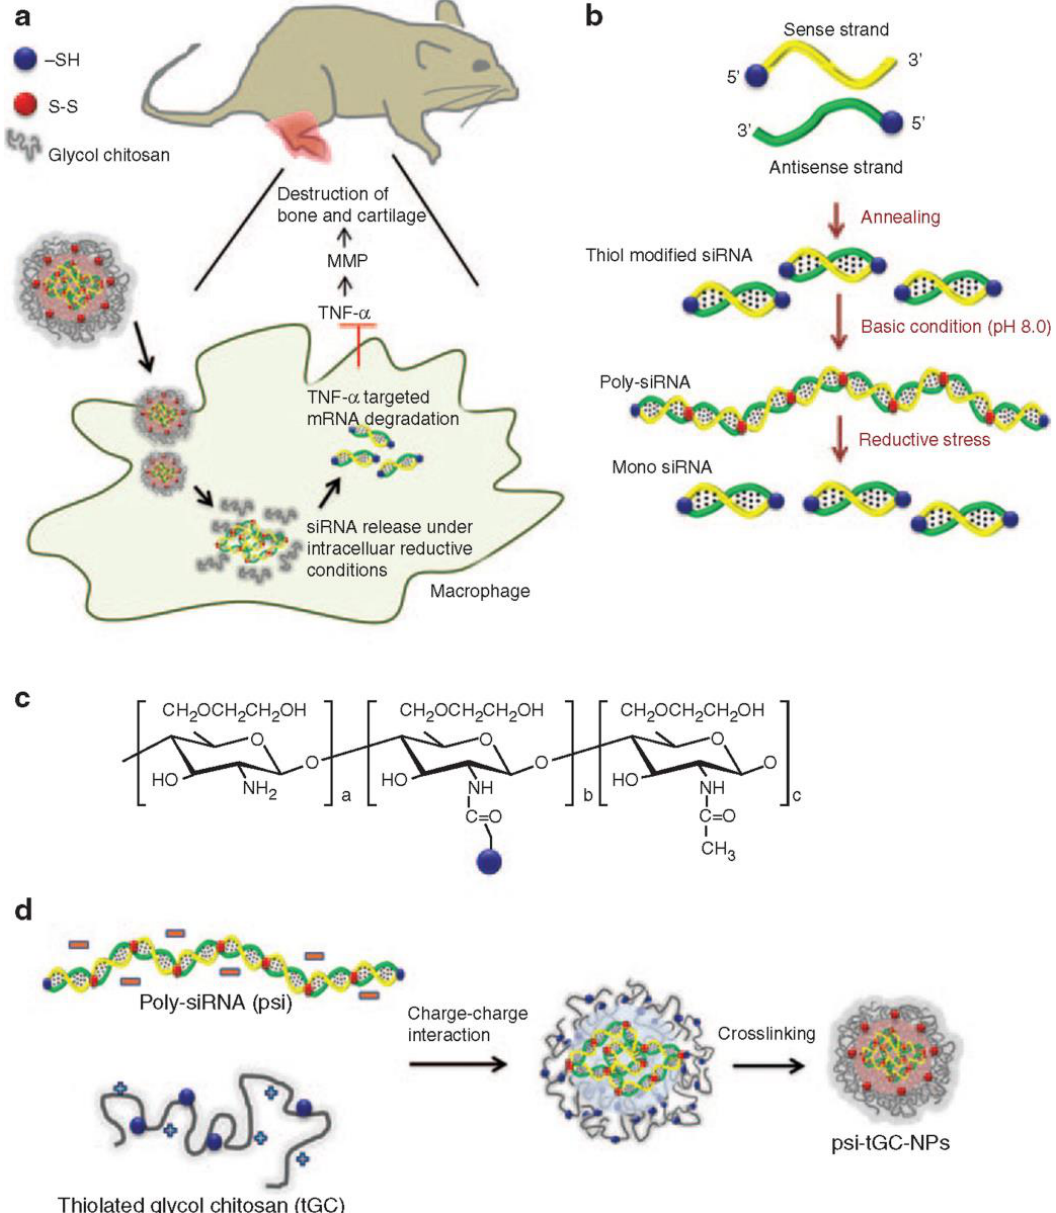
Figure 2. Polymerized siRNA/thiolated glycol chitosan nanoparticles (psi-tGC-NPs). ( a ) Cellular uptake of psi-tGC-NPs into macrophages resulting in TNF- α gene salience. ( b ) Preparation of poly-siRNA. ( c ) Structure of tGC polymers. ( d ) Complexation of poly-siRNA with tGC polymers. Reprinted with permission from Ref. [23]. Copyright © 2014 The American Society of Gene and Cell Therapy. Published by Elsevier Inc. All rights reserved.